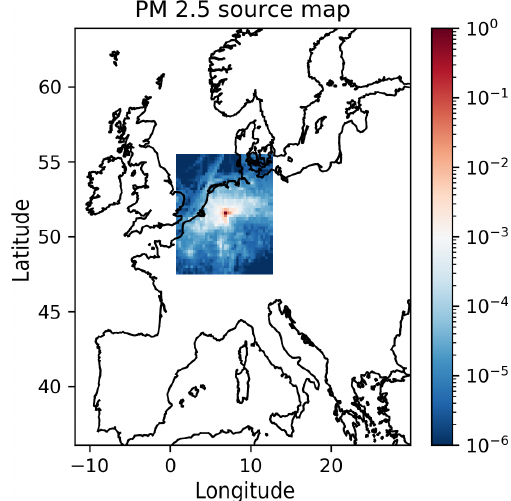
Figure 3. Example of local fractions as a source map. The values show the fraction of PM 2 . 5 that has been emitted at that location and transported to the central point. The sum of all the fractions is in this case 0.976, meaning that 2.4% of the PM 2 . 5 concentration at the central position originates from sources outside the local